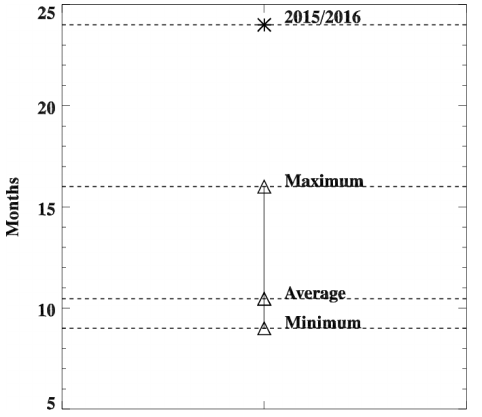
Figure 12. The minimum, average, and maximum periods (trian- gles) of the westerly zonal wind at 20hPa from 1958 to 2014. The star signal denotes the period of westerly zonal wind at 20hPa in